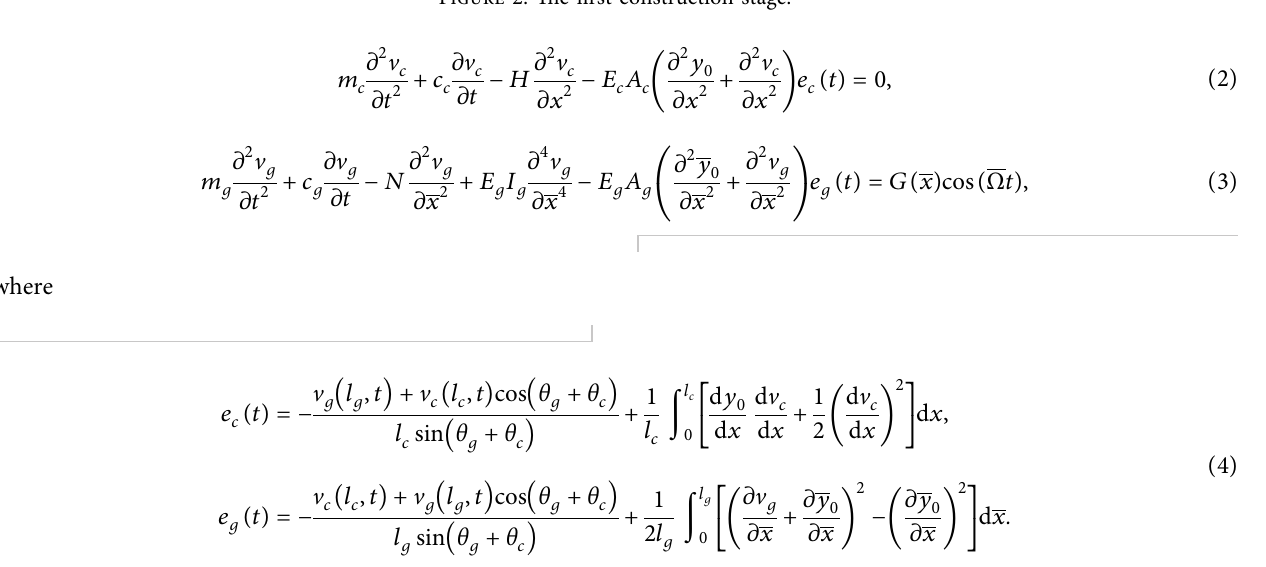
Figure 2: The first construction